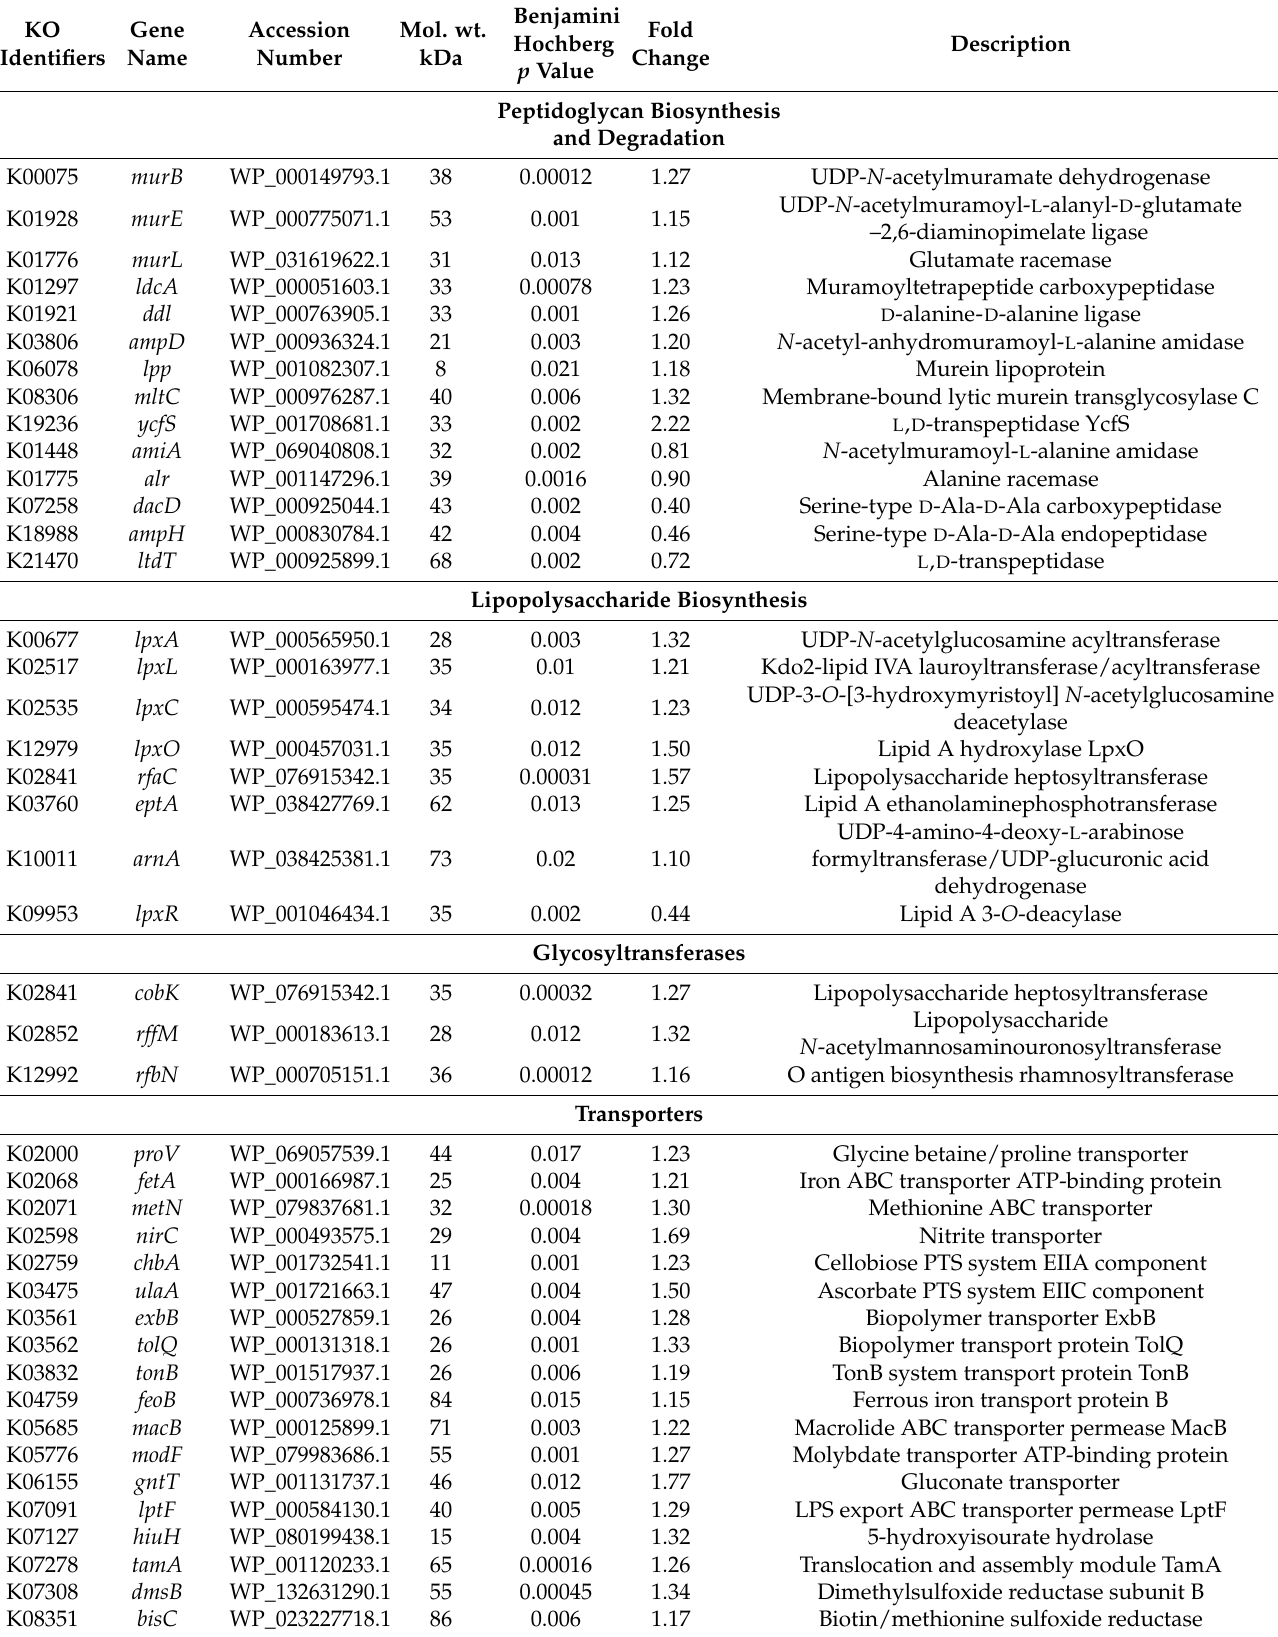
Table 1. Differential abundance of proteins in the ∆ cpxR background compared with that of the wild-type S . Enteritidis during the exponential growth